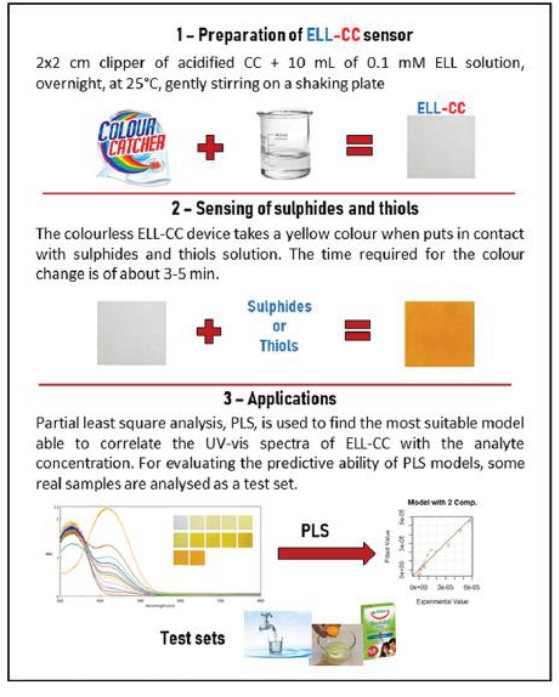
Figure 10. Preparation and application of the ELL-CC sensor [62].